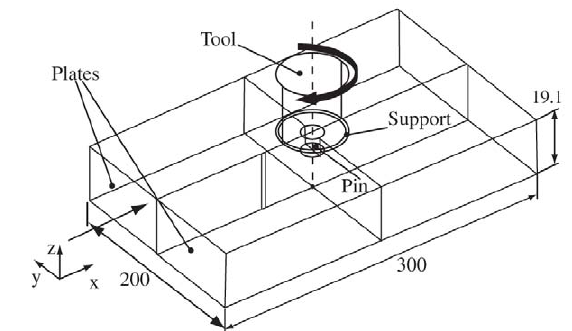
Figure 1. Schematic representation of the FSW